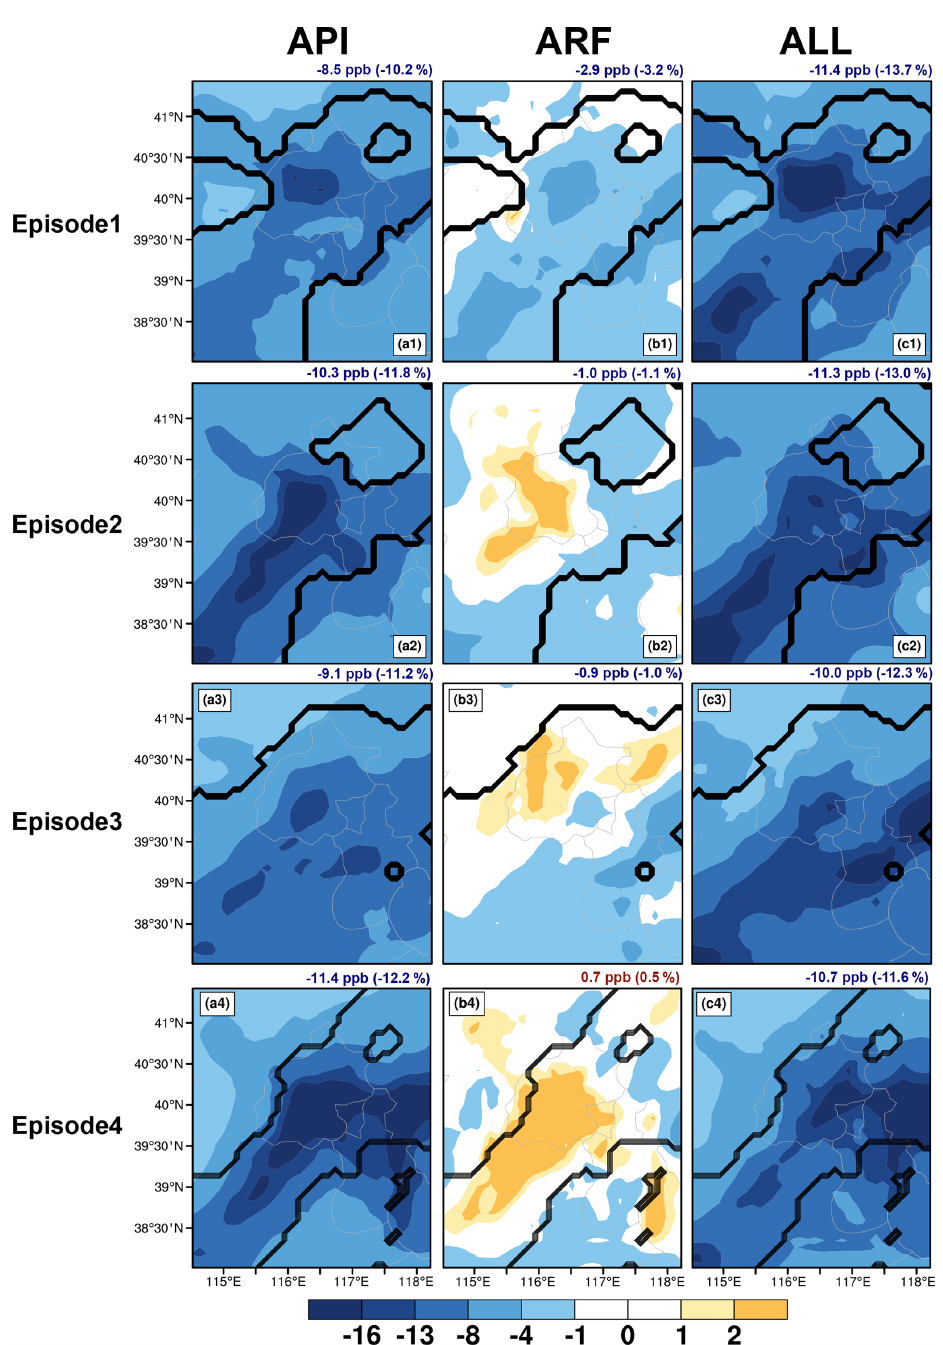
Figure 6. The changes in surface-layer ozone due to (a) aerosol–photolysis interaction (API), (b) aerosol–radiation feedback (ARF), and (c) the combined effects (ALL; defined as API + ARF) in the daytime (08:00–17:00LST) during 28 July to 3 August 2014 (Episode1), 8–13 July 2015 (Episode2), 5–11 June 2016 (Episode3), and 28 June to 3 July 2017 (Episode4). The changes (percentage changes) in O 3 concentrations caused by API, ARF, and ALL, averaged over CAPAs, are also shown at the top of each panel.